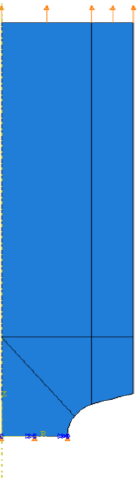
Figure 7. Boundary conditions.